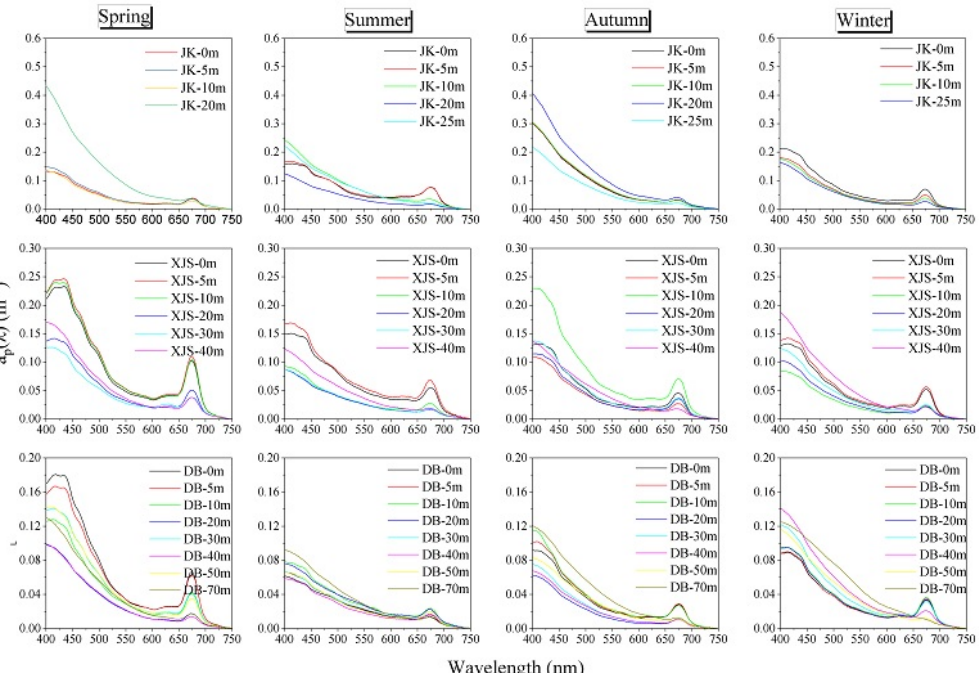
Figure 5. Seasonal variability of the total particle absorption spectra at different depths for sampling sites JK, XJS and DB in Lake Qiandaohu (see Figure 1). Table 3. Seasonal variation of a p ( 440 ) at sampling sites JK, XJS and DB.